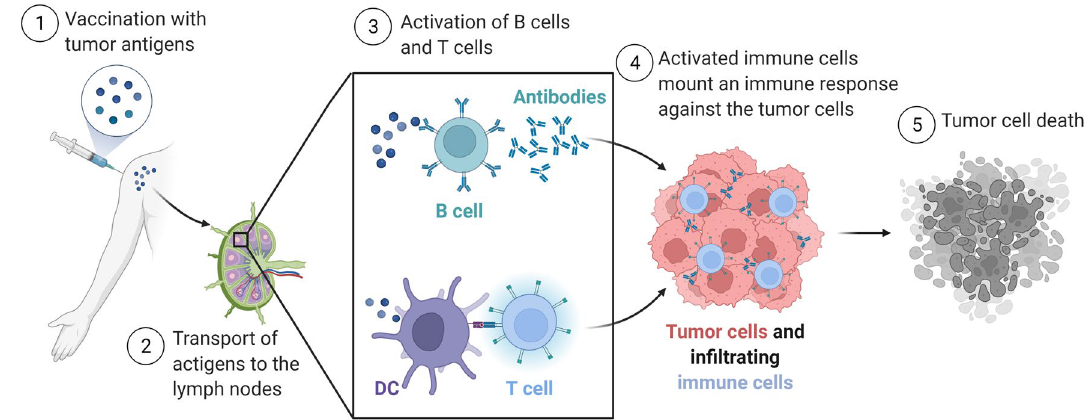
Fig. 1 Cancer vaccine. After vaccination, tumour antigens are carried to the lymph nodes, where they activate antigen-specific B and T cells. B cells recognize antigens directly, while T cells are activated by dendritic cells (DC) which process and present antigen on MHC molecules. Antibodies produced by activated B cells and activated effector T cells infiltrate tumours and induce tumour cell